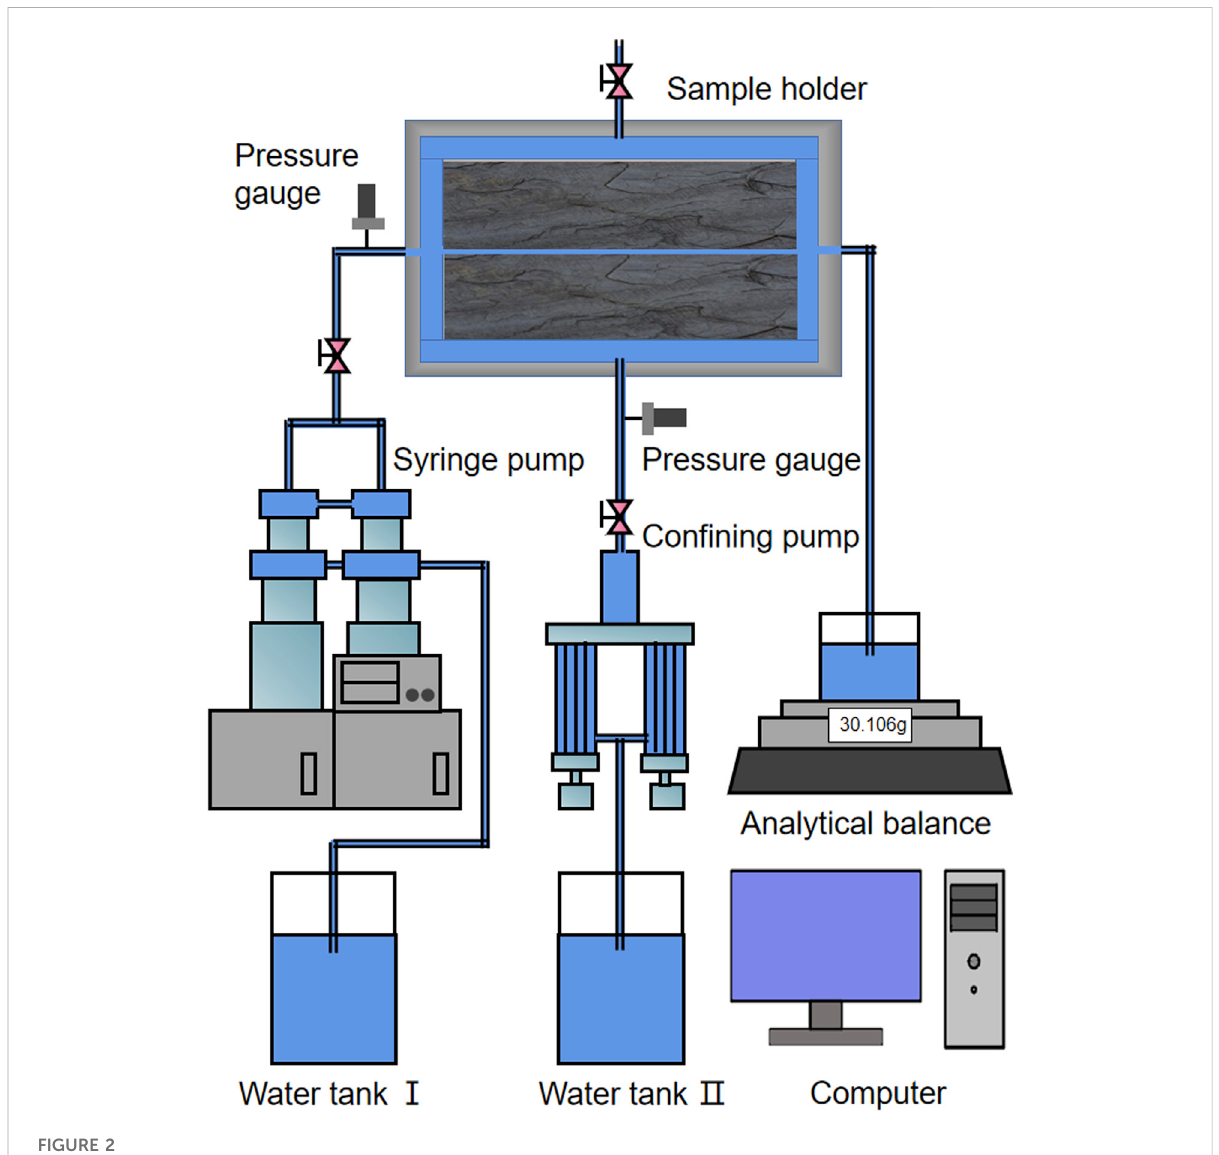
FIGURE 2 Experimental equipment